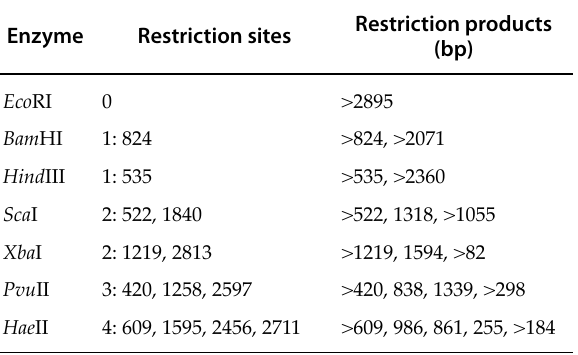
Table 4. Restriction enzymes selected for RFLP. Sites and expected size of products (bp) as inferred by the 2895 bp Dhpg sequence.